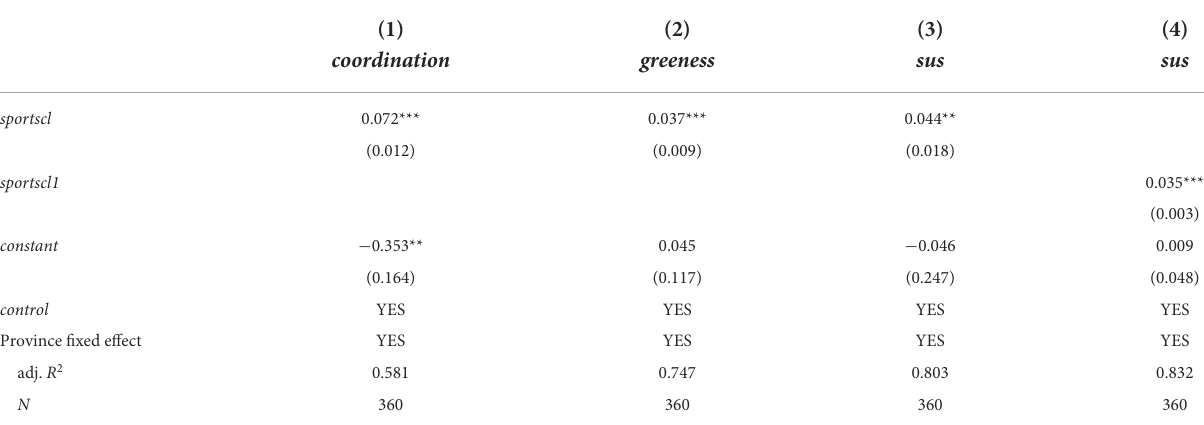
TABLE 4 The robustness checks.